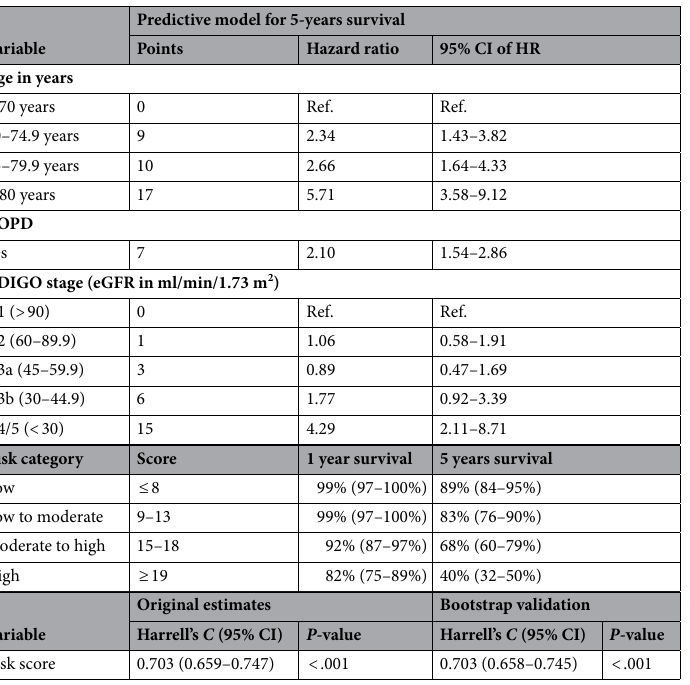
Table 4. Risk score. Predictive score based on Cox proportional hazard model. Complete-case analysis, n = 552 of 558, missing data as presented in Table 1; number of events was 197; global test for statistical significance of the model, LR-test: P < .001. 1 year and 5 years survival are presented with 95% confidence interval in brackets. COPD chronic obstructive pulmonary disease; not having the condition served as reference group. eGFR estimated glomerular filtration rate according to the “Modification of Diet in Renal Disease Study” equation and grouped according to the KDIGO